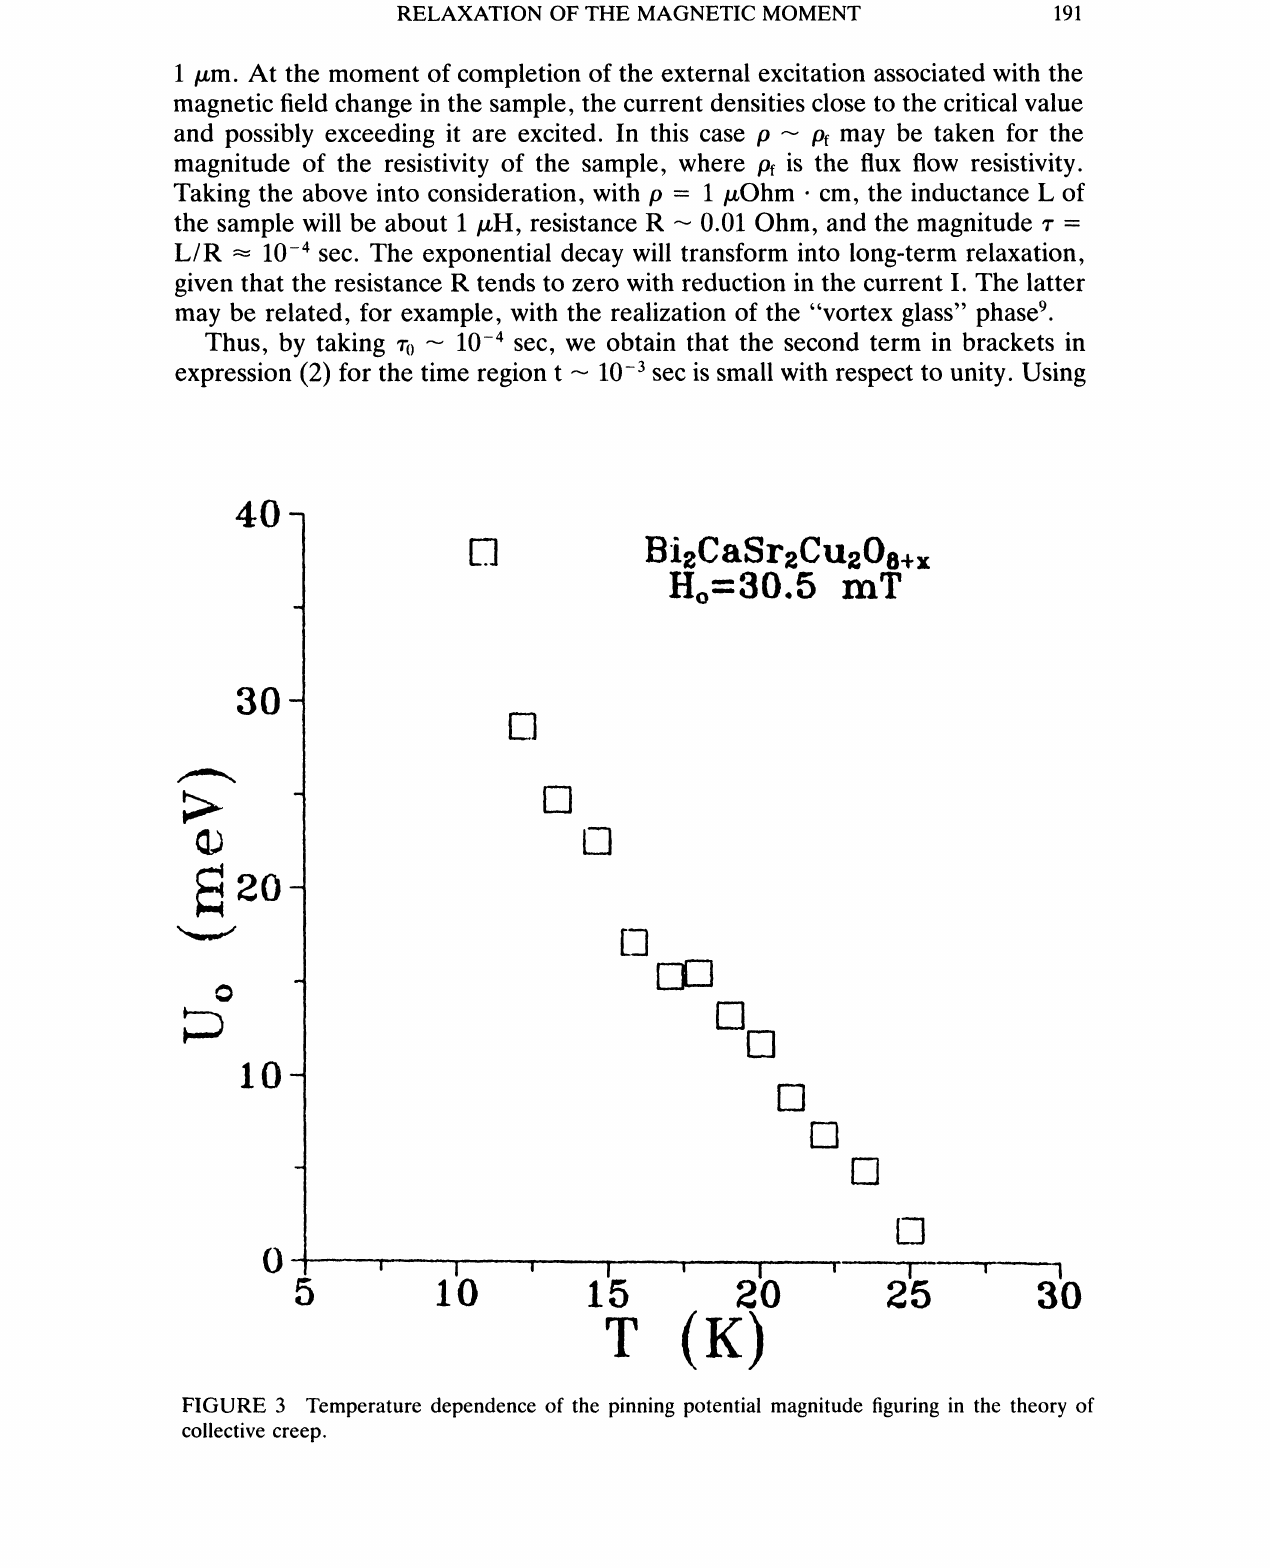
FIGURE 3 Temperature dependence of the pinning potential magnitude figuring in the theory of collective